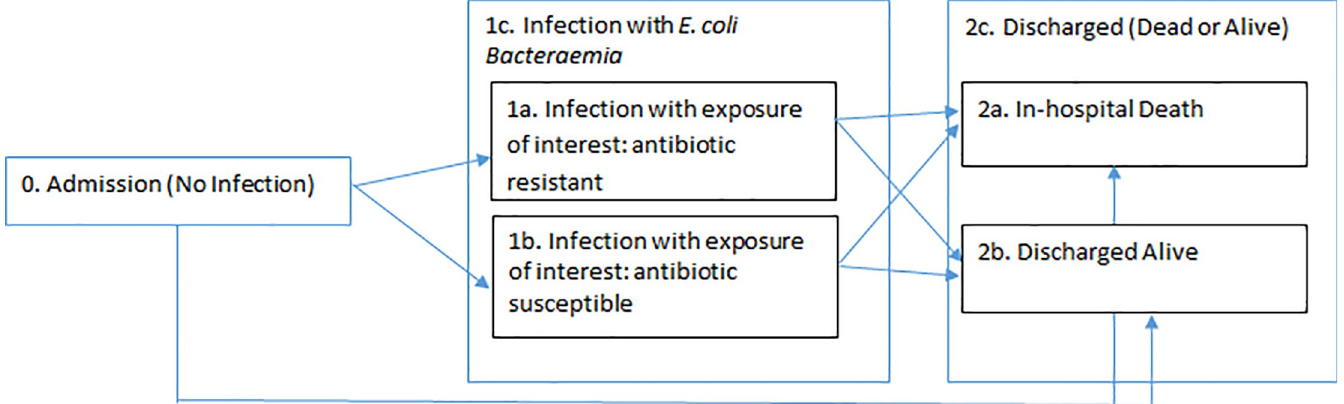
Fig 2. Multistate model schematic for excess length of stay estimation. Potential health states are depicted by the boxes and the direction in which they may travel depicted via arrow directionality. State 0 = “Admission, No Infection”, State 1 = “Infection of Interest” with 1a relating to infections with resistant E . coli , 1b infections with susceptible E . coli and composite state 1c being all E . coli infections, state 2a = “In-hospital Death” and state 2b = “Discharge Alive”. States 2a and 2b, together, form the LoS endpoint, 2c.